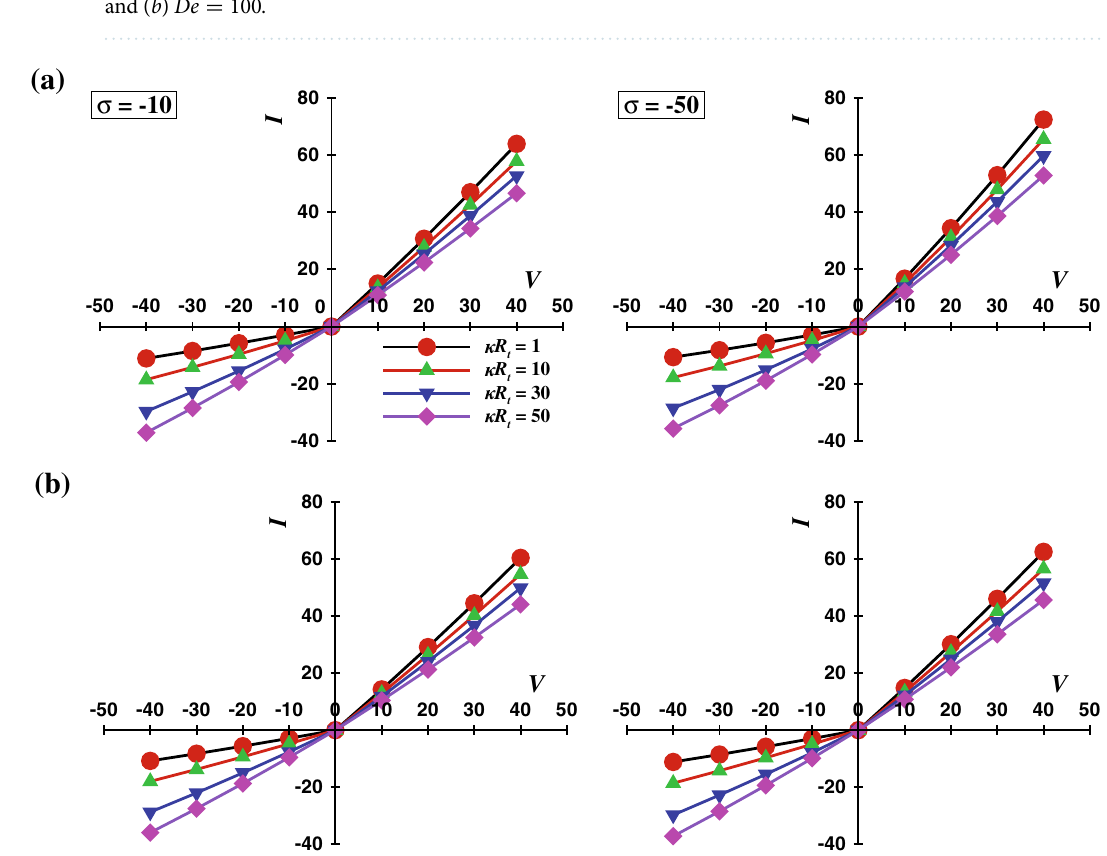
Figure 13. I vs V curve at different values of κ R t at De = 100 (a) ε = 0.05 and (b) ε = 0.25